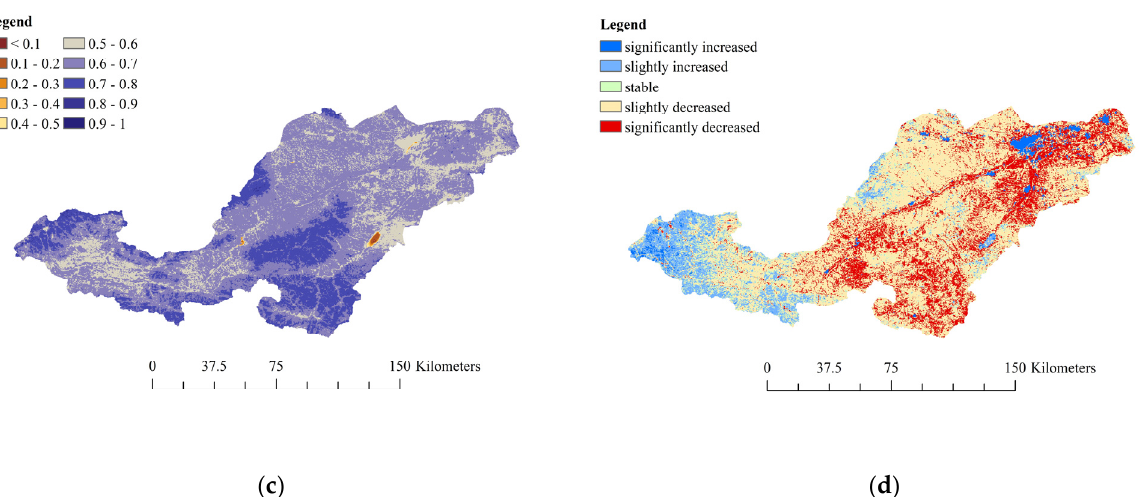
Figure 3. Interannual variation characteristics of actual evapotranspiration: ( a ) interannual variation of actual evapotranspiration (ETa); ( b ) spatial distribution of ETa multiyear mean; ( c ) the Cv spatial distribution of ETa; ( d ) spatial distribution of ETa trend change.